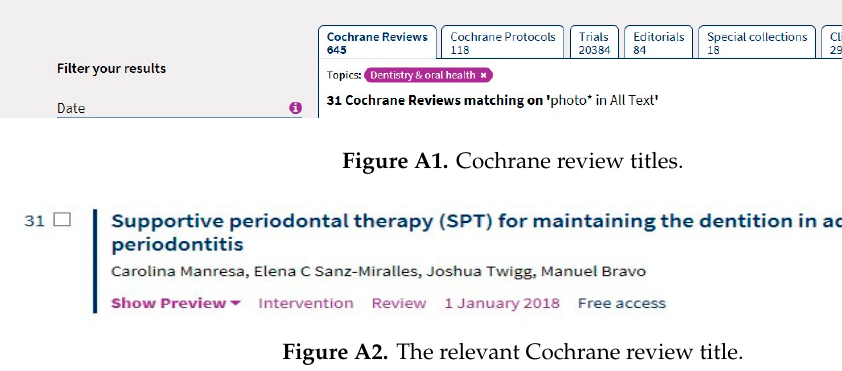
Figure A2. The relevant Cochrane review title. Table A4. The five full-text studies excluded in this review.